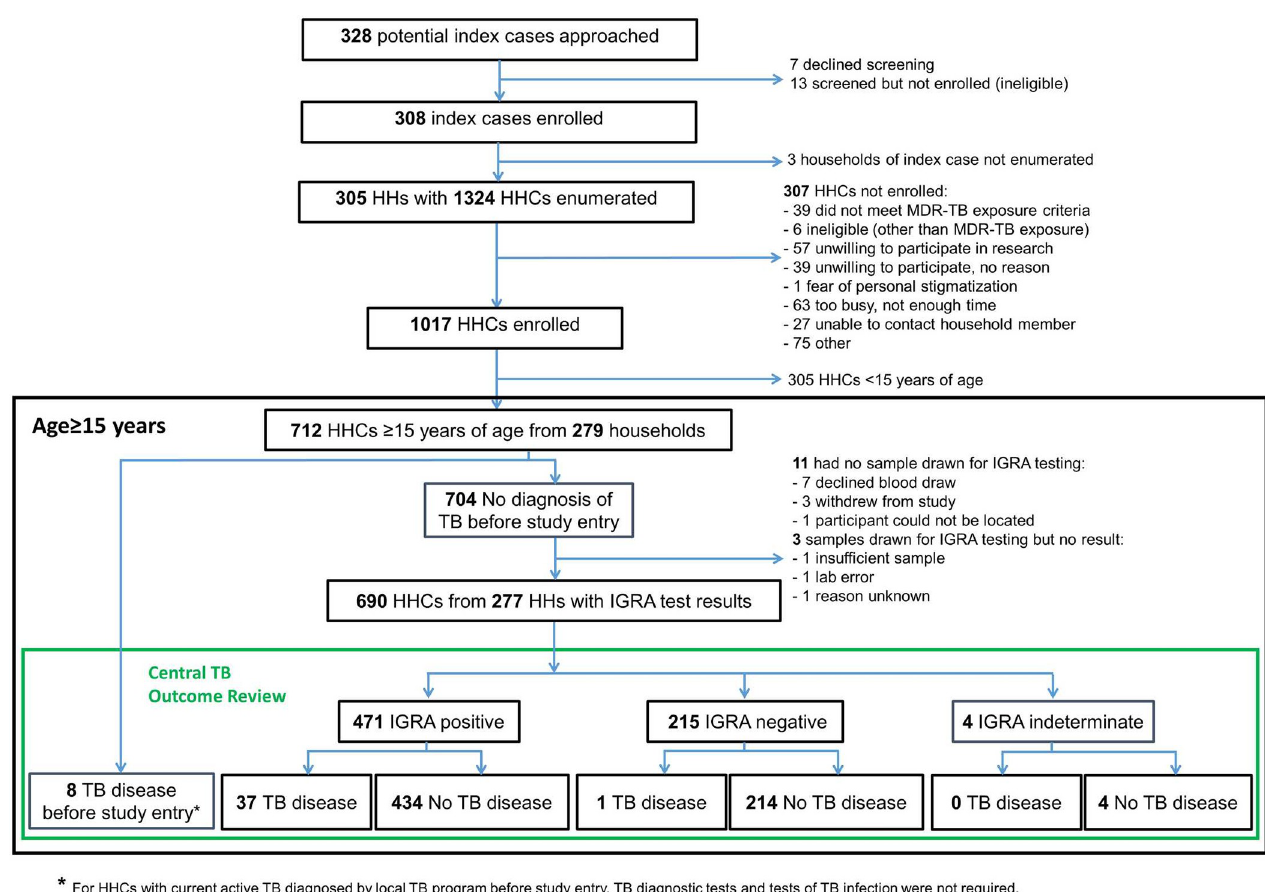
Fig 1. Participant flow diagram. Abbreviations: HH, Household; HHC, household contact; IGRA, interferon-gamma release assay.